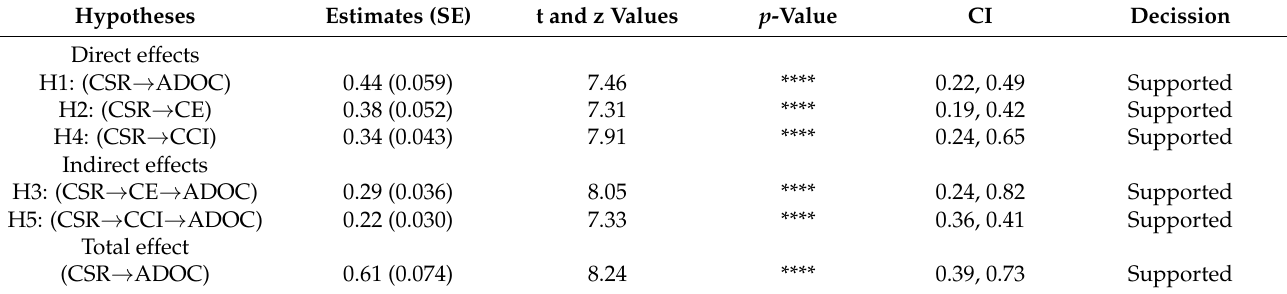
Table 6. Hypotheses